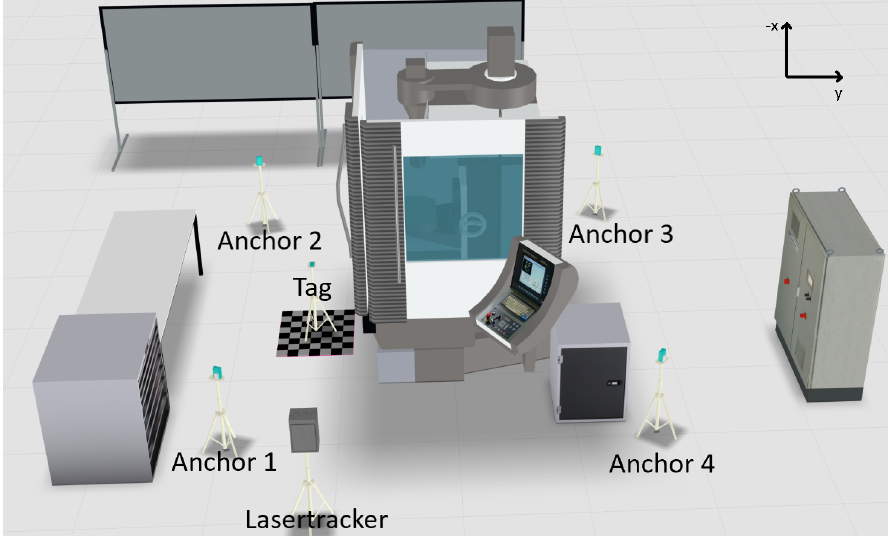
Figure 5. Visualization scenario 1: Two lines of sight.